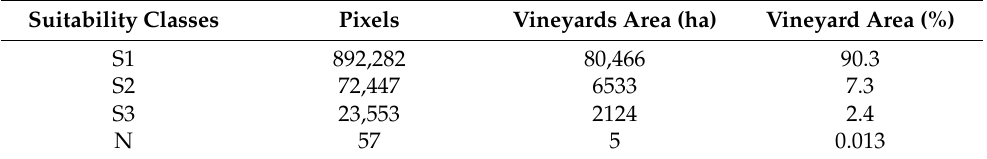
Figure 7. Suitable areas for table grape production in Afghanistan based on fuzzy multicriteria decision analysis. Table 3. Potential areas belonging to the suitable classes based on fuzzy algorithms for Afghanistan.